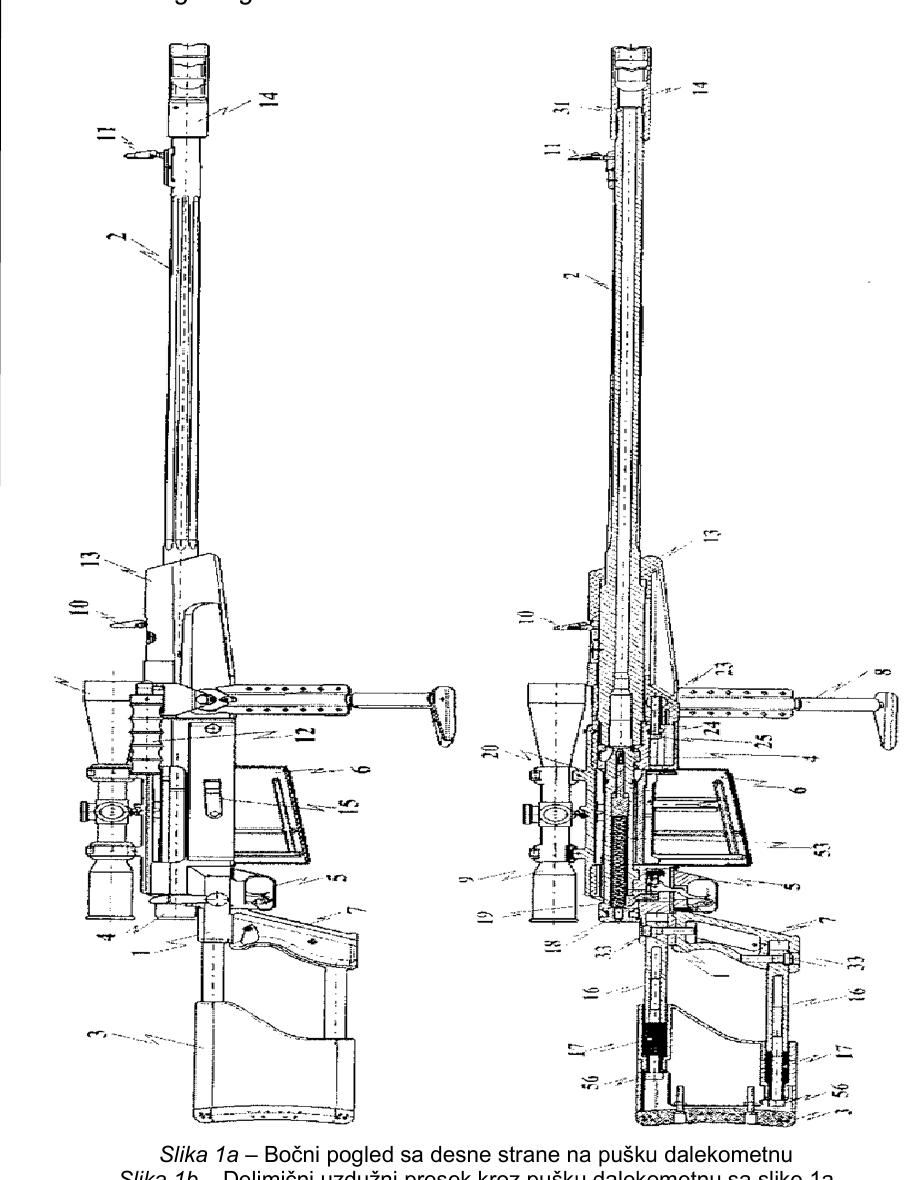
Figure 1a – Side view of the right side of the long-range rifle Figure 1b – Partial longitudinal section through the long-range rifle in Figure